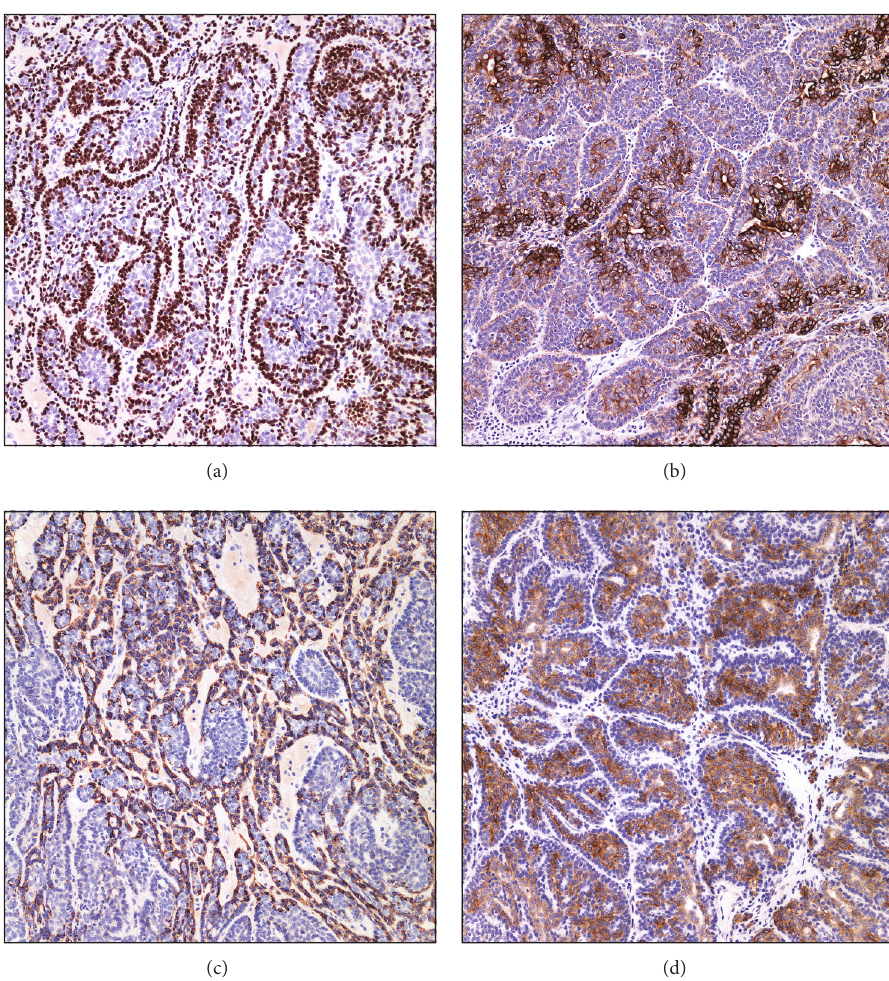
Figure 2: Immunoprofile of two-cell populations in eccrine spiradenoma. Basaloid cells are immunoreactive for P63 and calponin (a and c) and larger cells near the center of the clusters are immunoreactive for CK7 and CD117 (C-kit) (b and d). Both cell types are negative for ER, PR, AR, and HER2 expression (not